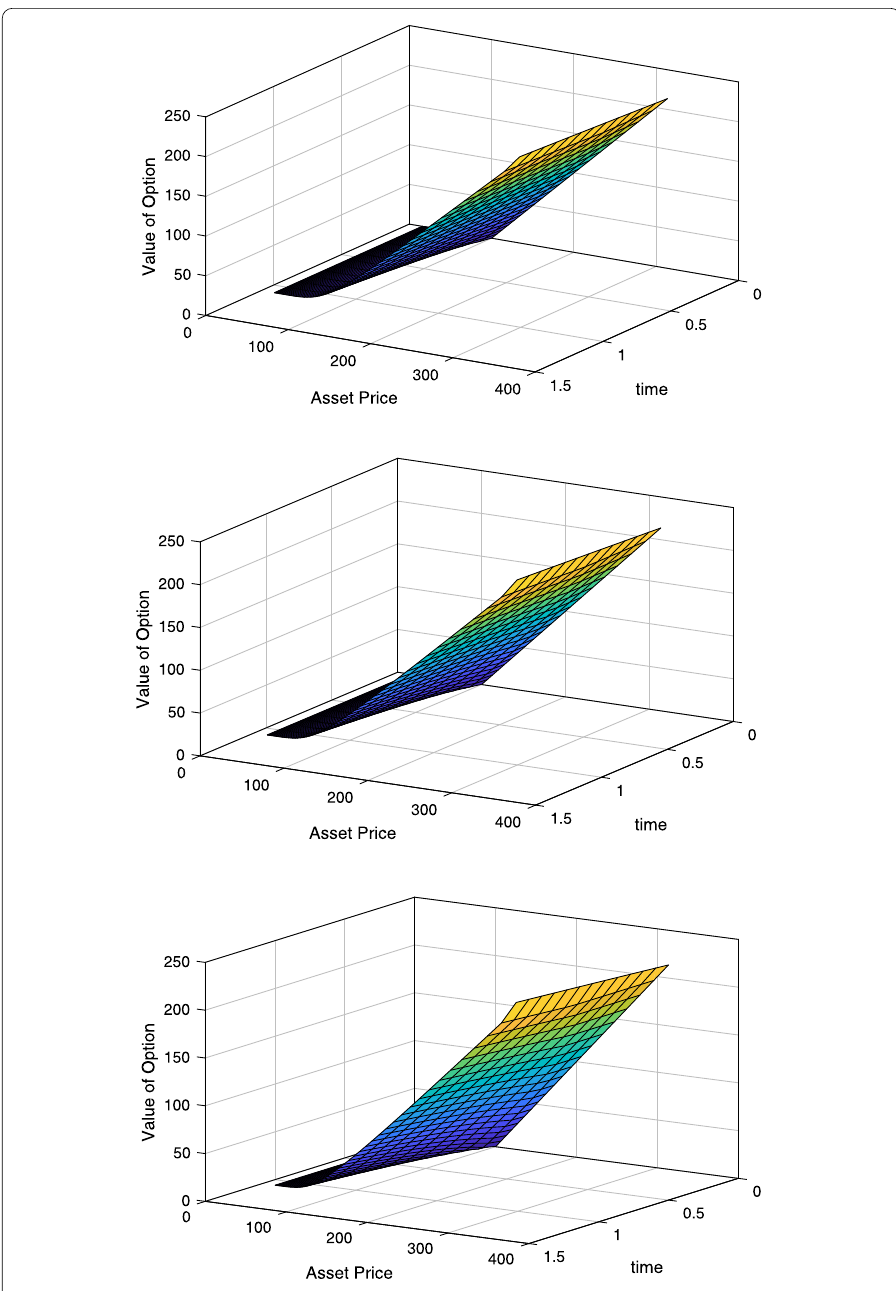
Figure 3 American call option prices versus asset prices. Price of option at various states of economy as a function of stock price and time for American call options under the Merton jump-diffusion model. (up) First state of economy ( λ = 0.3). (center) Second state of economy ( λ = 0.5). (down) Third state of economy ( λ = 0.7) with M = 50, N = 10, and S = 70